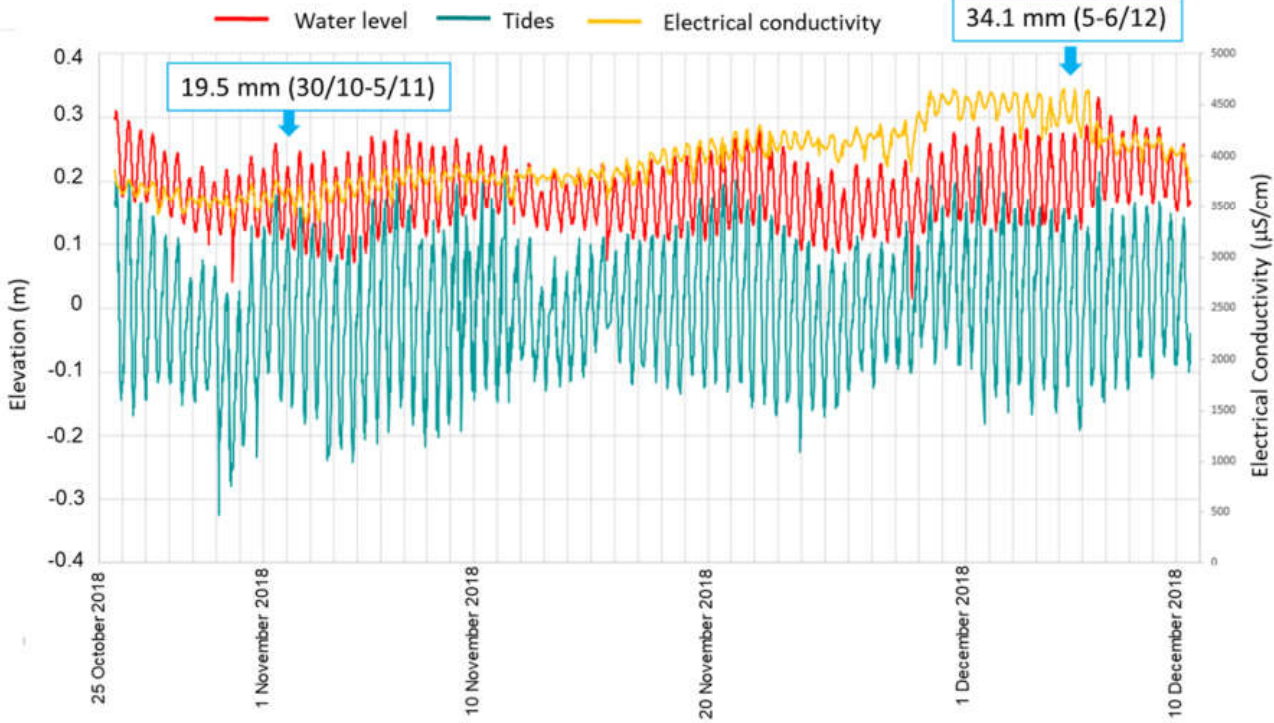
Figure 3. Well RGI_021–fluctuations with time of groundwater level (red), electrical conductivity (yellow), and sea water level due to tides (blue) between October and December 2018.